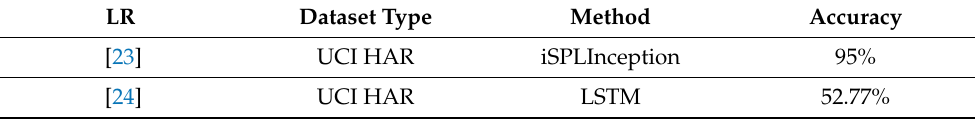
Table 7. Results ofboth DNN and RNN for specific movements of wrist-worn